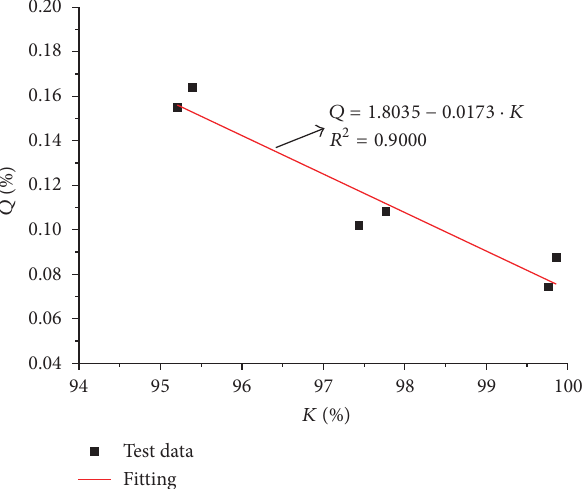
Figure 9: Relation between soaking swelling 𝑄 and compaction degree K .